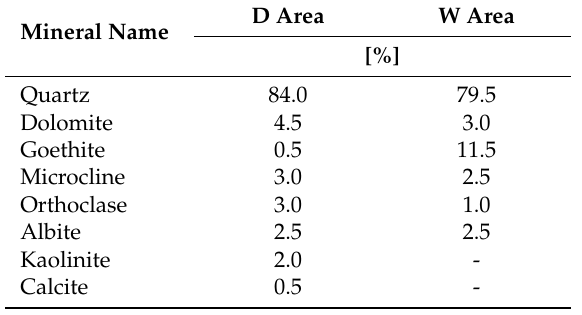
Table 3. Semiquantitative mineralogical analysis of XRD results.